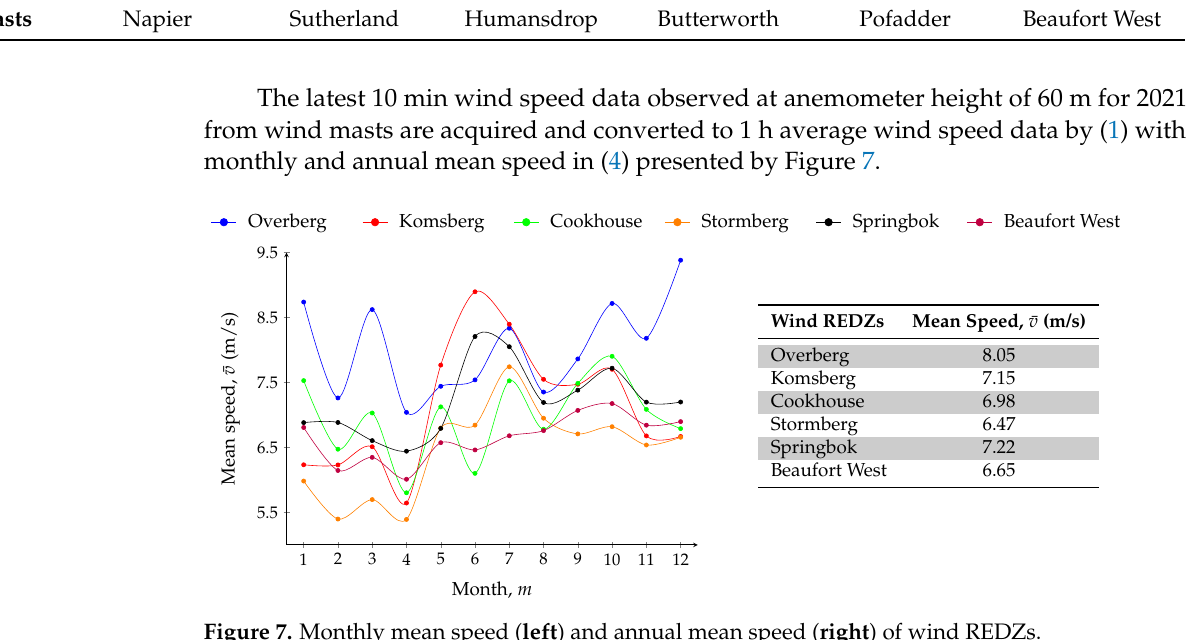
Table 2. Wind REDZs with corresponding wind masts.